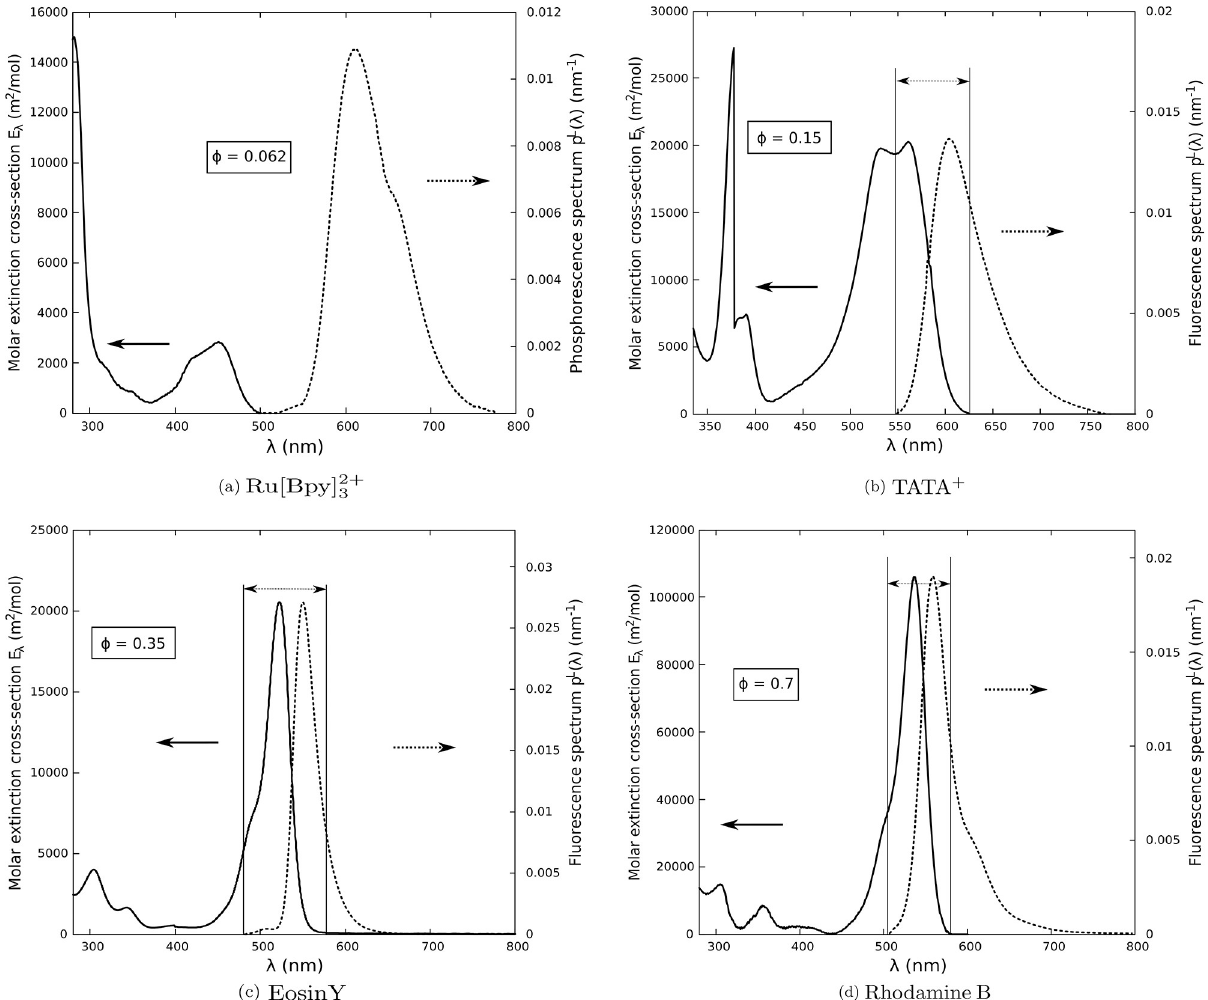
Fig 2. Photosensitizer radiative properties. In all plots, plain lines stand for UV-visible molar extinction cross-section spectrum E λ and dashed lines for luminescence emission spectrum p L ( λ ). Luminescent quantum yield F is provided in a box. (a) Ru[Bpy] 3 Cl 2 (40 μ M) in aqueous buffer (pH 6.8) solution [48]. (b) TATA(Cl) (0.5 mM) UV-visible molar extinction cross-section, TATA(Cl) (10 μ M) fluorescence emission spectrum and quantum yield under argon in acetate buffer (1 M) at pH 4.5 [25] (c) Eosin Y (24 μ M) in a mixture of triethylamine (10% vol.) in water at pH 10.5 [18, 21] (d) Rhodamine B in ethanol [26, 49]. Extinction cross-sections are obtained assuming that absorbance A λ measured by the authors cited above using spectrophotometry experiments can be interpreted as A λ = 1 − exp( − E λ CL ). Overlapping between molar extinction cross-section and luminescence emission spectrum is represented for each photosensitizer (except Ru[Bpy] 3 Cl 2 for which no overlapping is observed) by 2 parallel lines linked by a double arrow. Fig 2. Since these properties depend on the solvent, working conditions were selected to cover